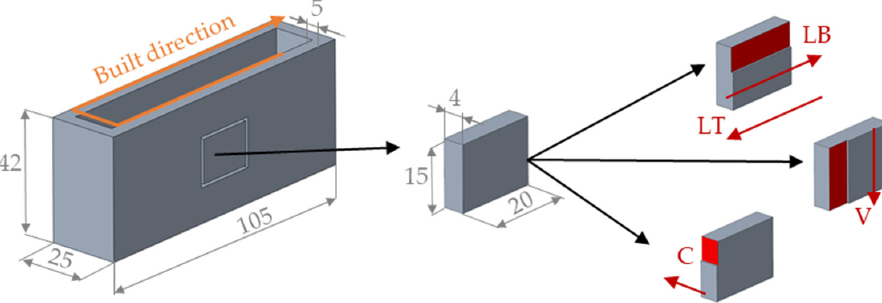
Figure 1. Dimensions of the reference component and investigated specimen directions.